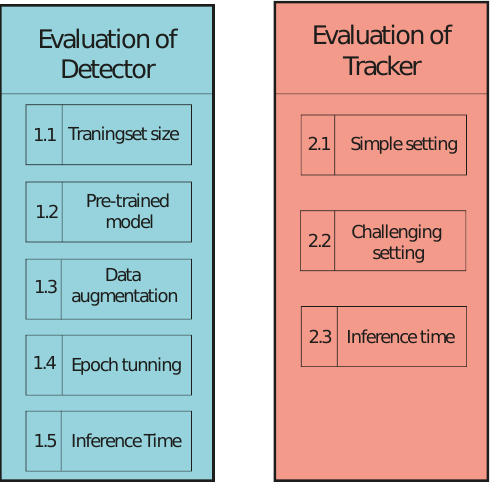
Figure 14. Overview of the different evaluation